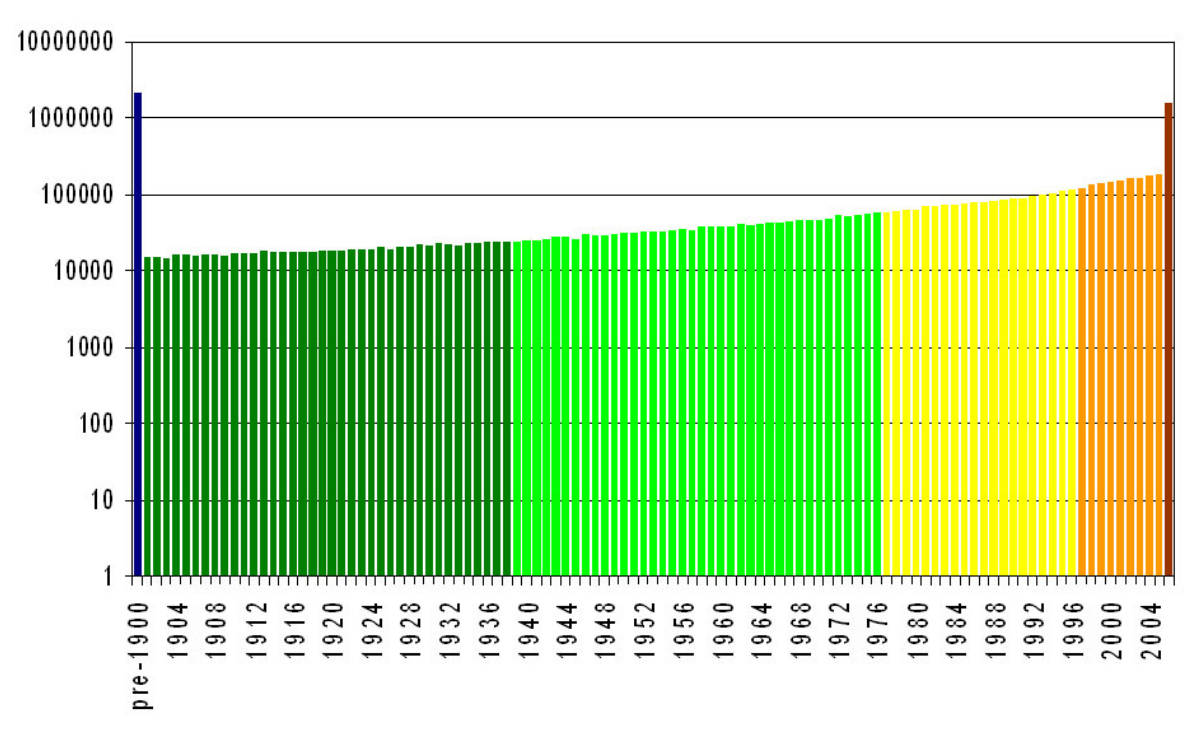
Fig. 5 . Count of the number of cells in each of the groundwater travel times by date and land-change submodel. The colors match those in Fig.